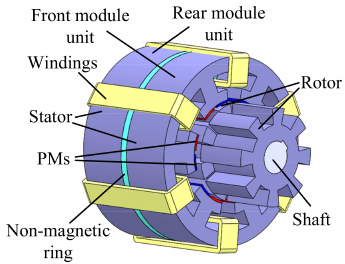
Figure 1. Topology of AM-FRPM